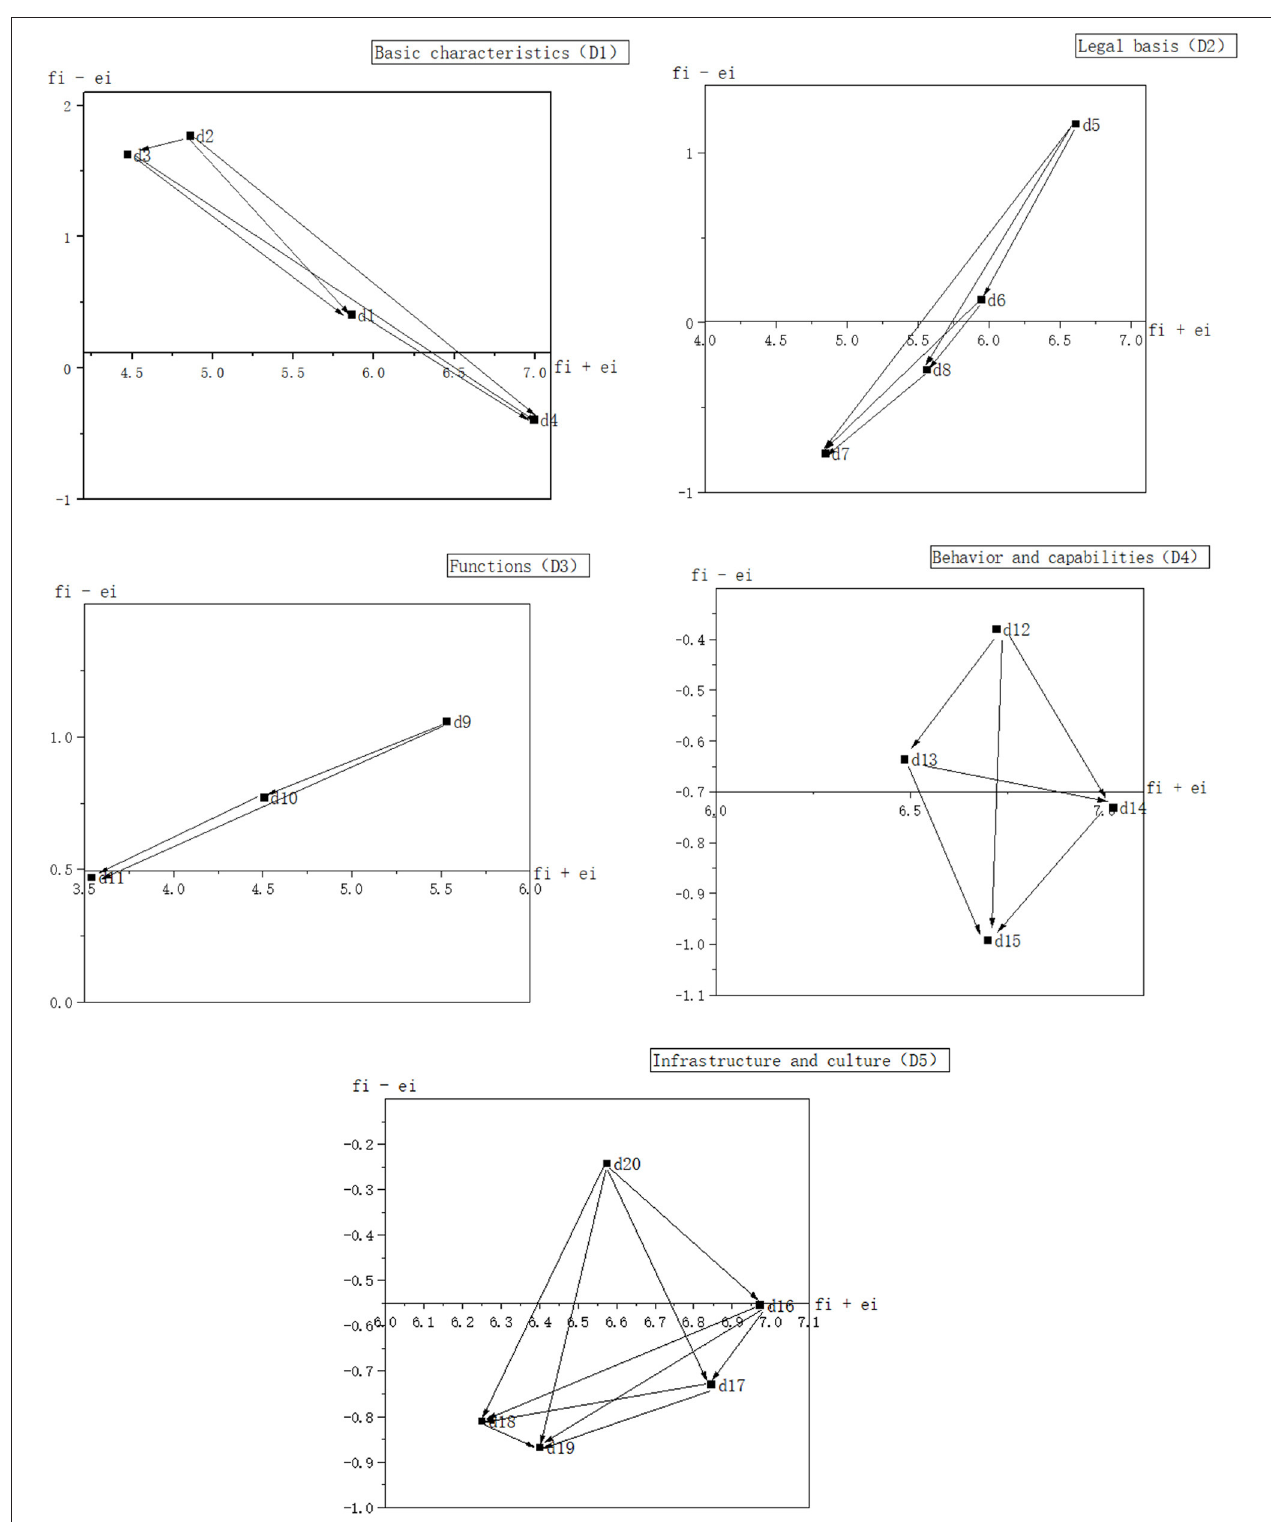
FIGURE 2 | Influence relation map of factors affecting public-public collaboration for food safety risk management.